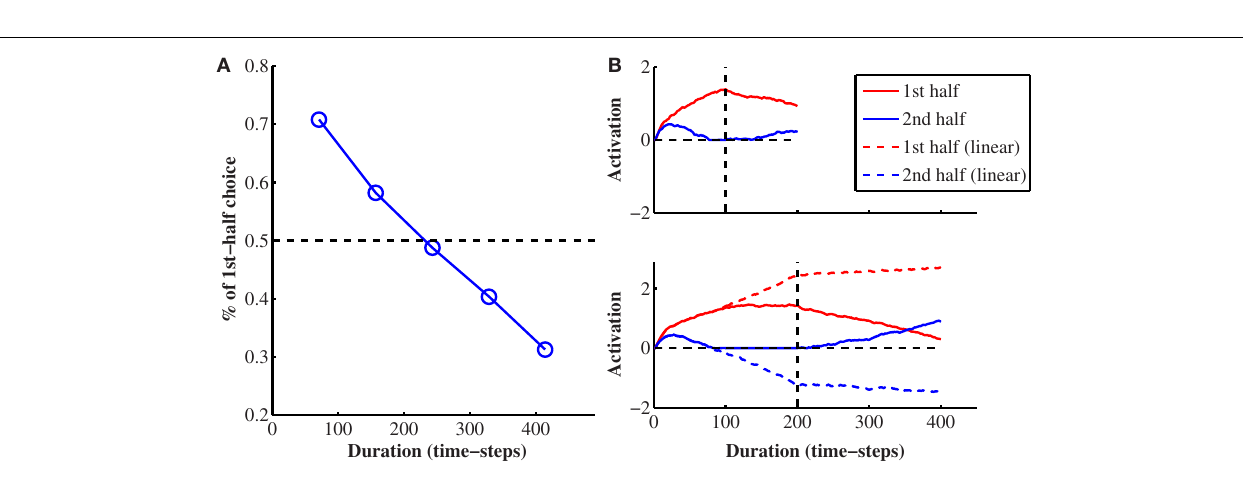
FIGURE 5 |The transition from primacy-to-recency as stimulus duration increases. (A) Probability of choices toward the alternative supported in the first half of the trial in the switch condition. See text for parameter values. (B) Activity trajectories of the two accumulators when stimulus duration is